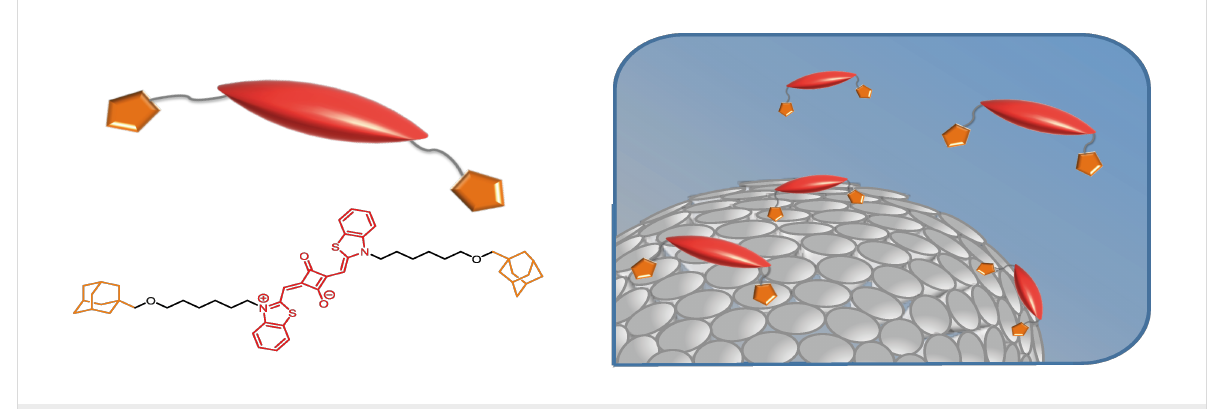
Figure 1: Schematic representation of adamantane-substituted squaraine (AdSq) binding as a divalent guest to the surface of cyclodextrin vesicles (CDV).